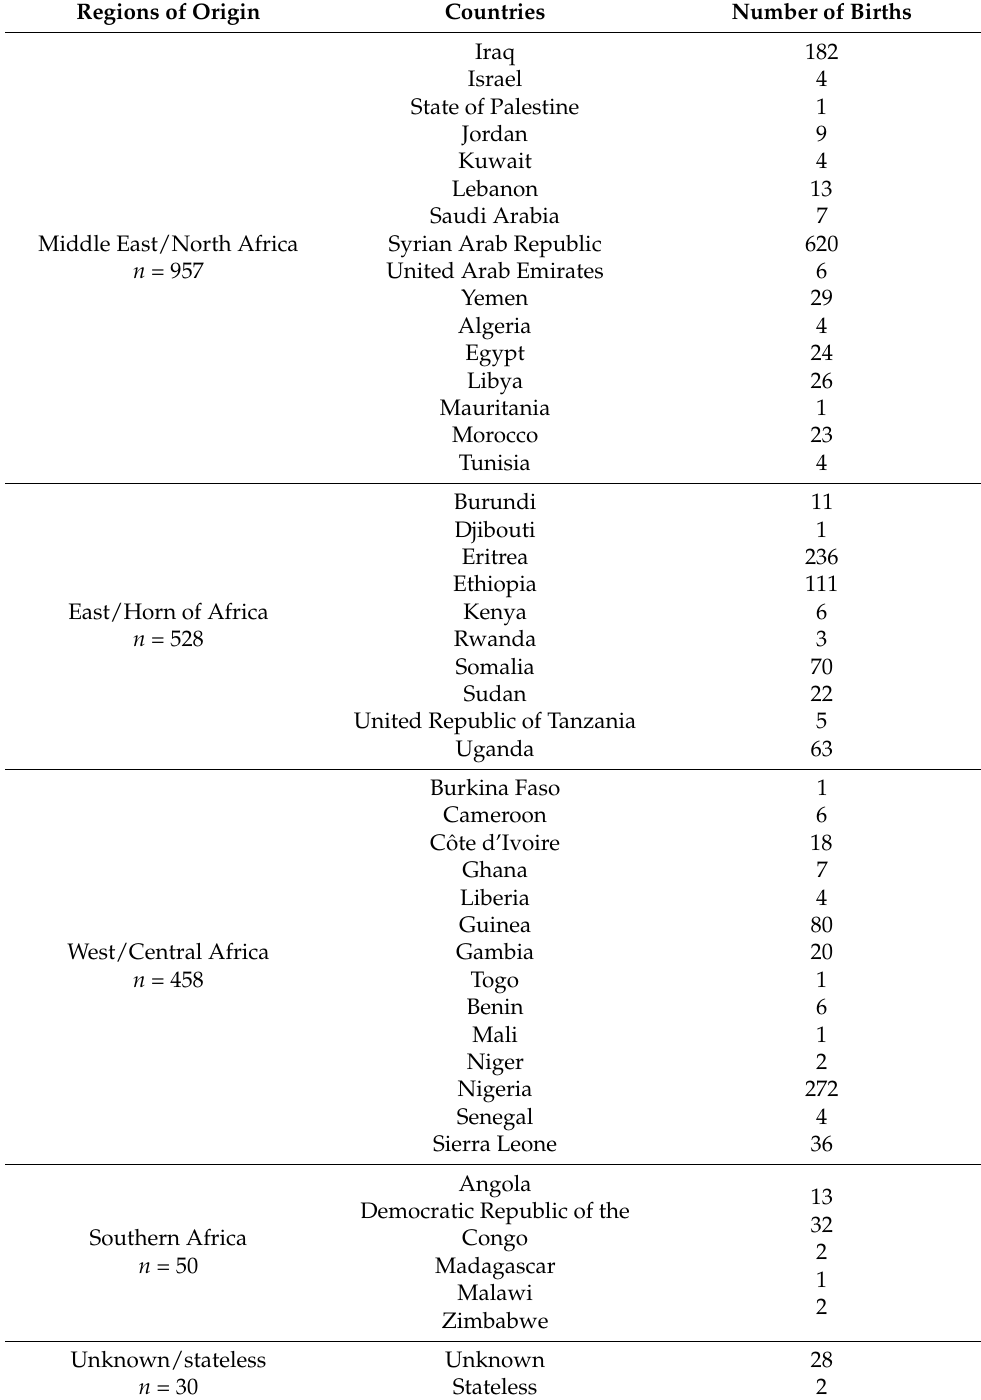
Table A2. Cont. Regions of